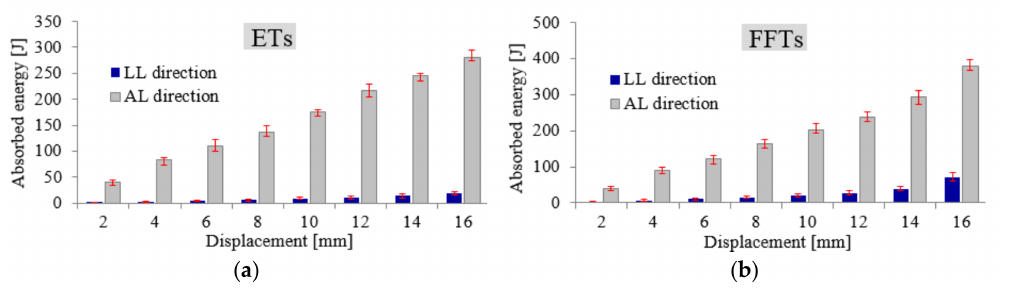
Figure 6. A comparison of axial and lateral energy absorption values for ETs ( a ) and FFTs ( b ) sample